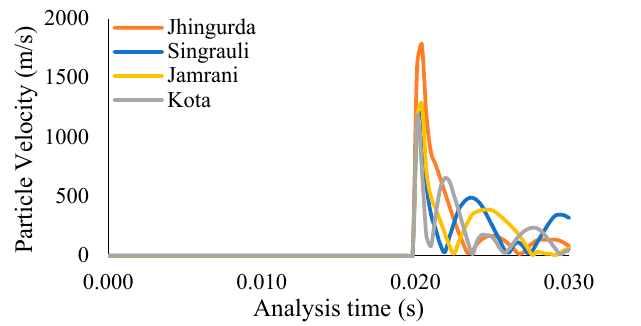
Figure 7. Comparison of particle velocity at ground surface under present impact loading condition.